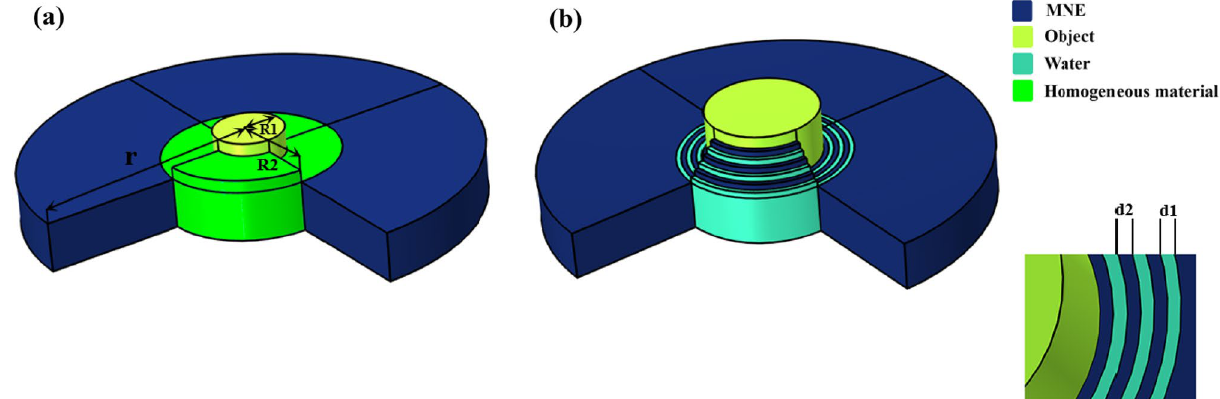
Figure 1. ( a ) Schematic of homogeneous cloak composed of anisotropic materials in MNE substrate and ( b ) schematic of a multilayer cloaking consisting of water and MNE in the MNE